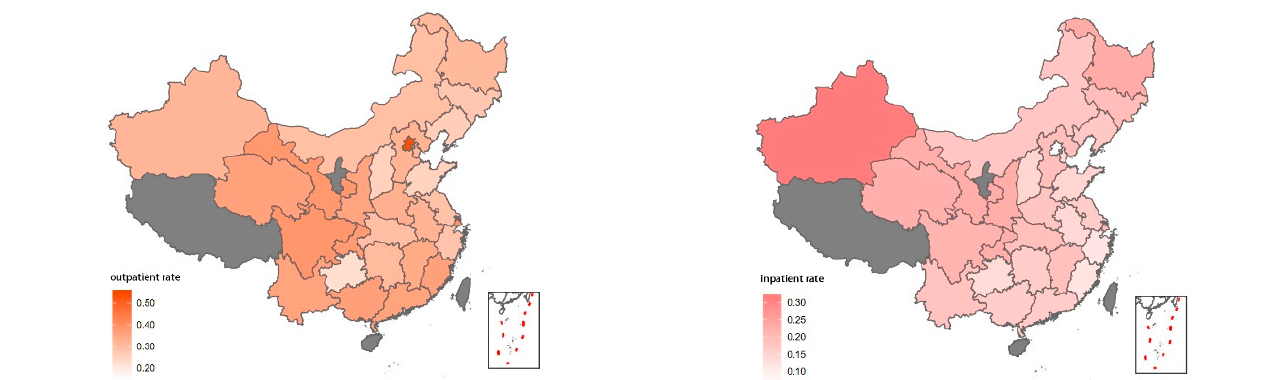
Figure 3. Geographic healthcare services utilization in China in 2015.